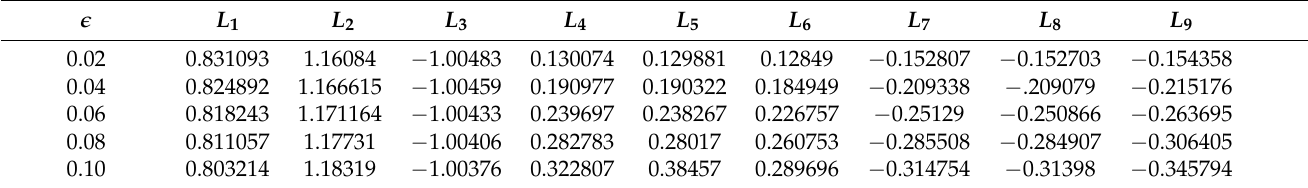
Table 2. Values of perturbed collinear Lagrangian points at different values of the parameter (cid:101) .